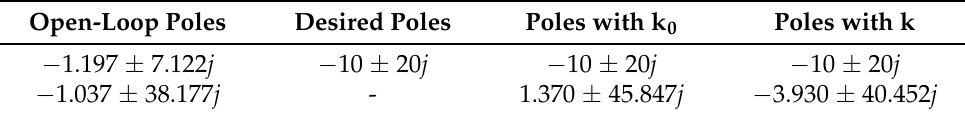
Figure 5. Test case 2: closed-loop poles. Table 3. Test case 2: open-loop and closed-loop